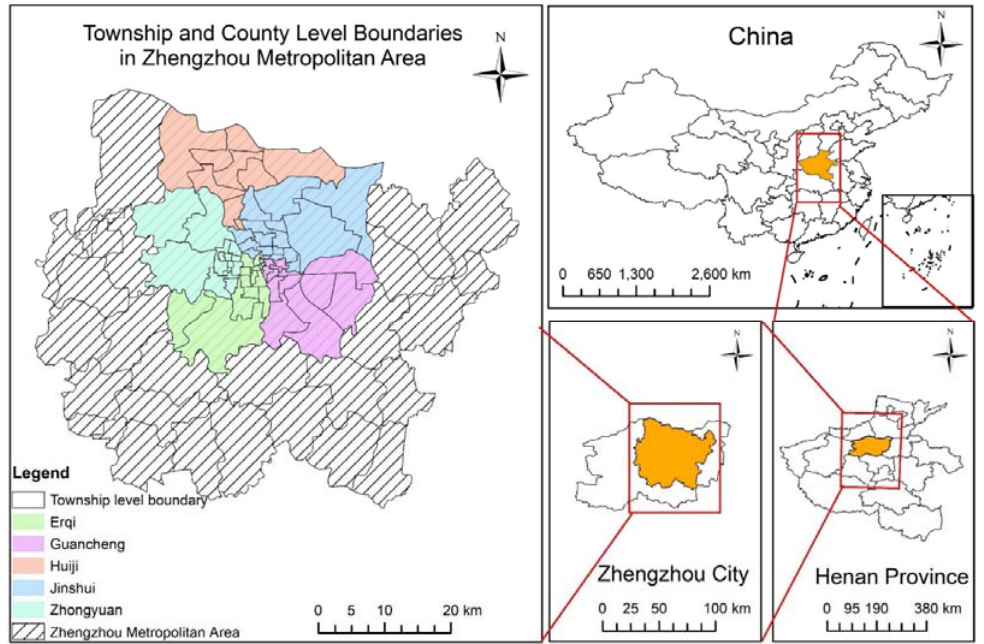
Figure 1. Map of the Zhengzhou metropolitan area in the context of Zhengzhou, Henan and China.